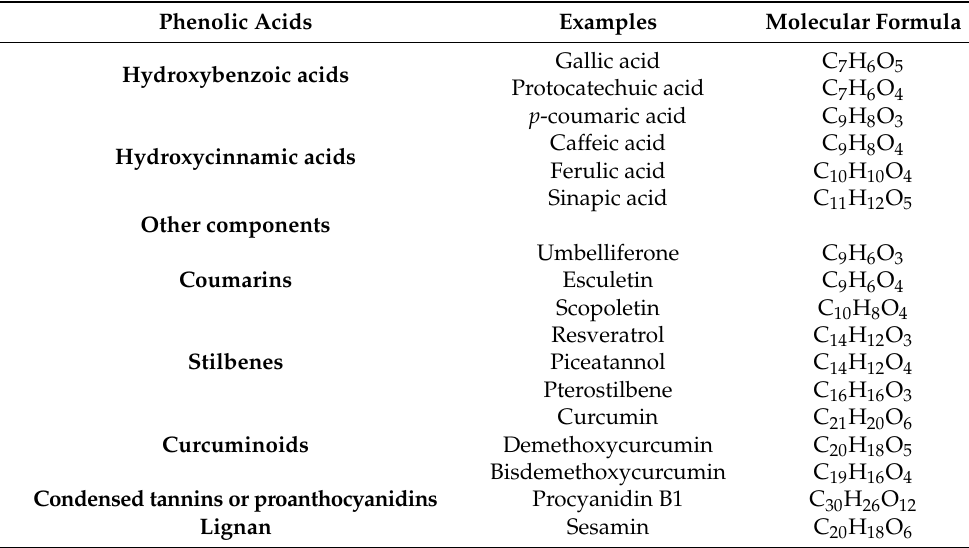
Table 2. Examples of hydroxybenzoic and hydroxycinnamic acids. Phenolic Acids Examples Molecular